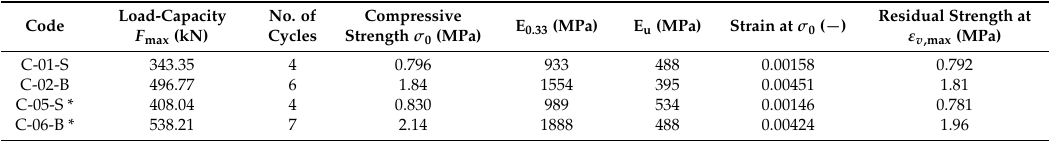
Figure 7. Compression tests: ( a ) C-01-S; ( b ) C-06-B. Table 2. Results of compression